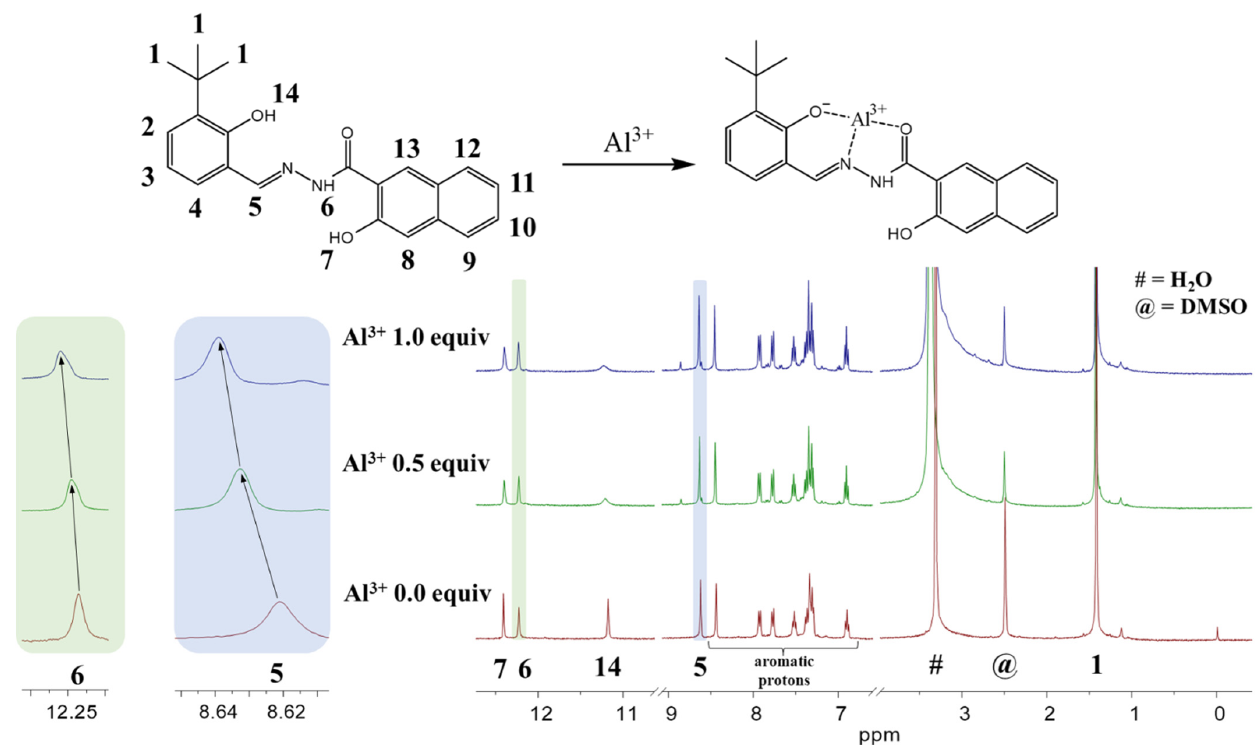
Figure 4. 1 H NMR titration of NATB with Al 3+ in DMSO- d 6 .